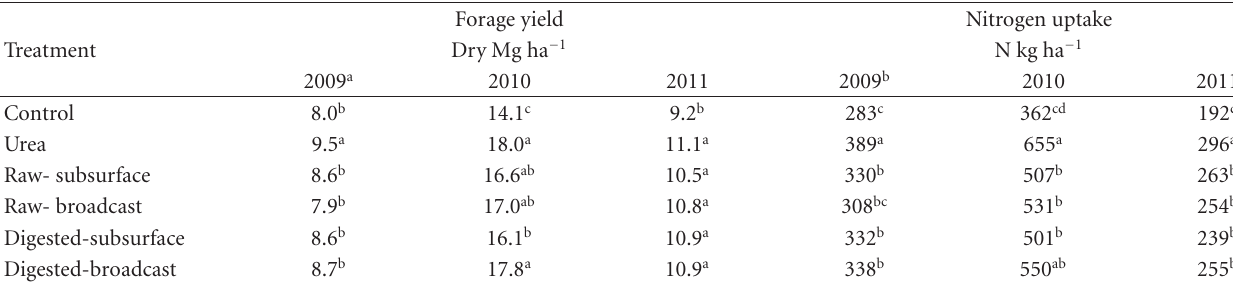
Table 6: Annual forage yield and N uptake, 2009 to